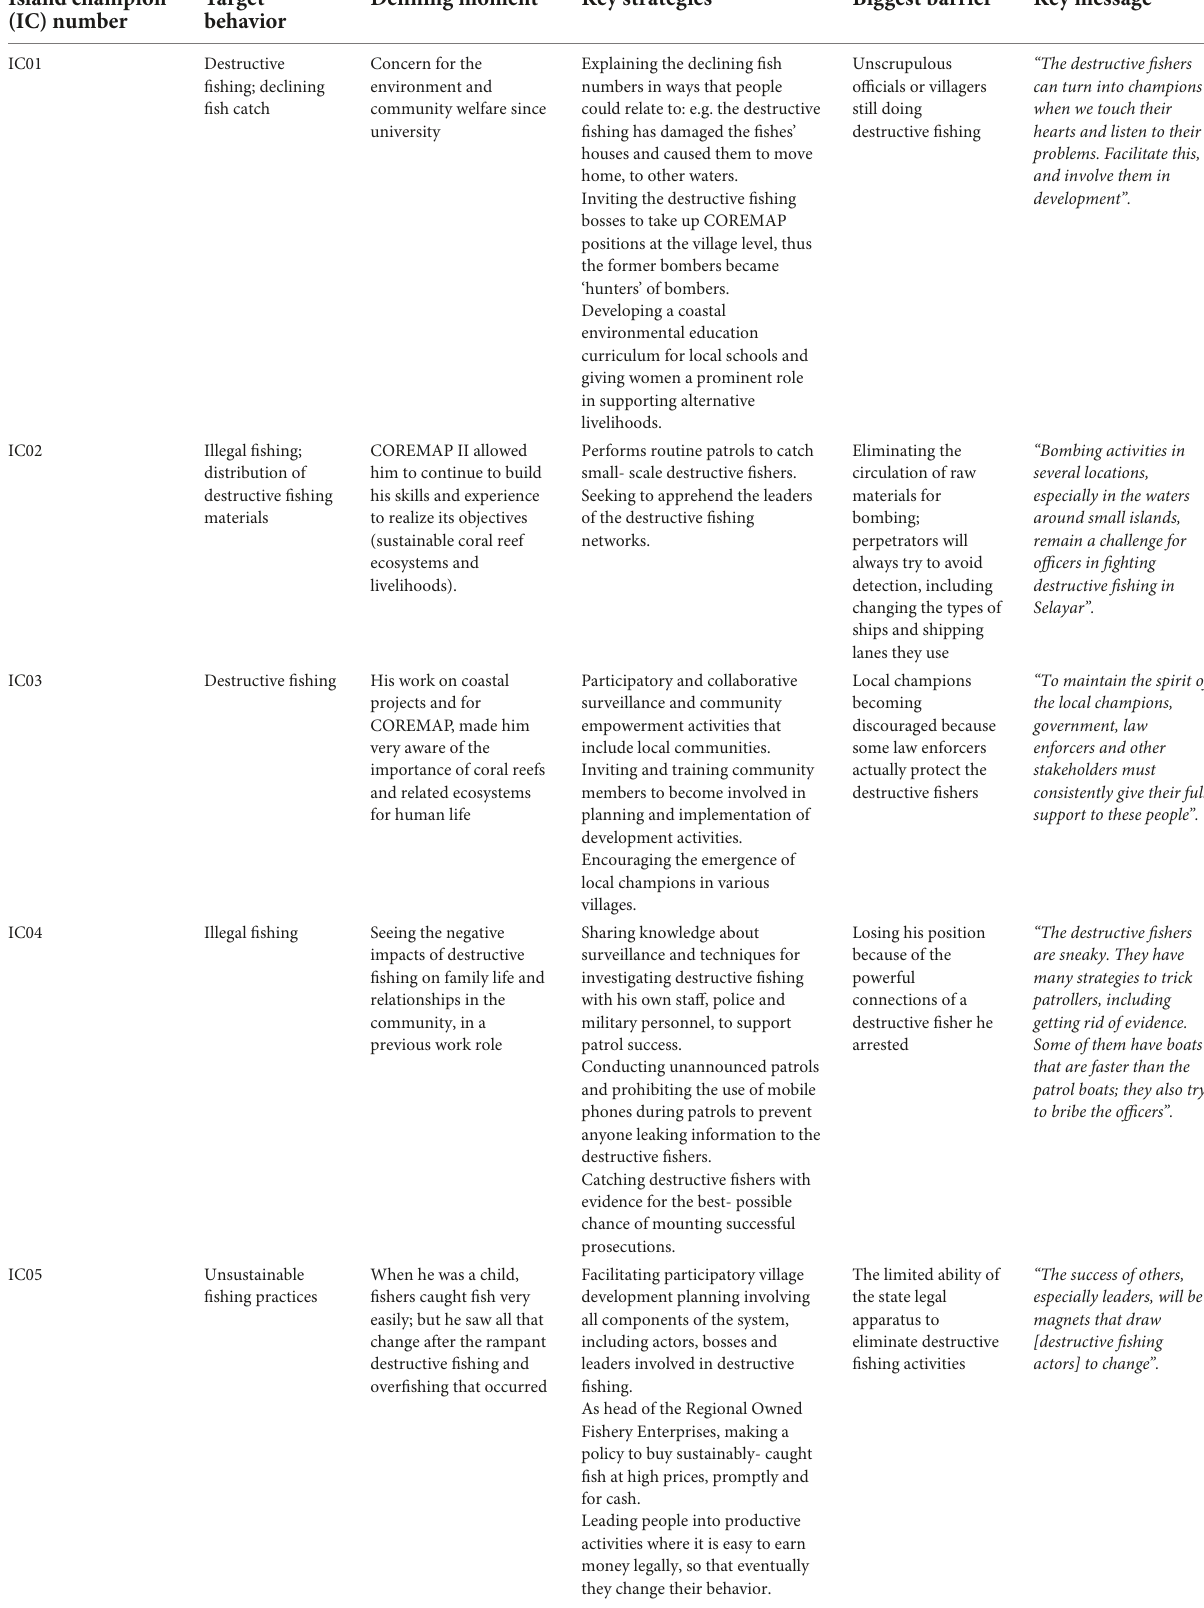
TABLE 2 Summary of island champions, their strategies, barriers and messages. Island champion Target Defining (IC) number behavior